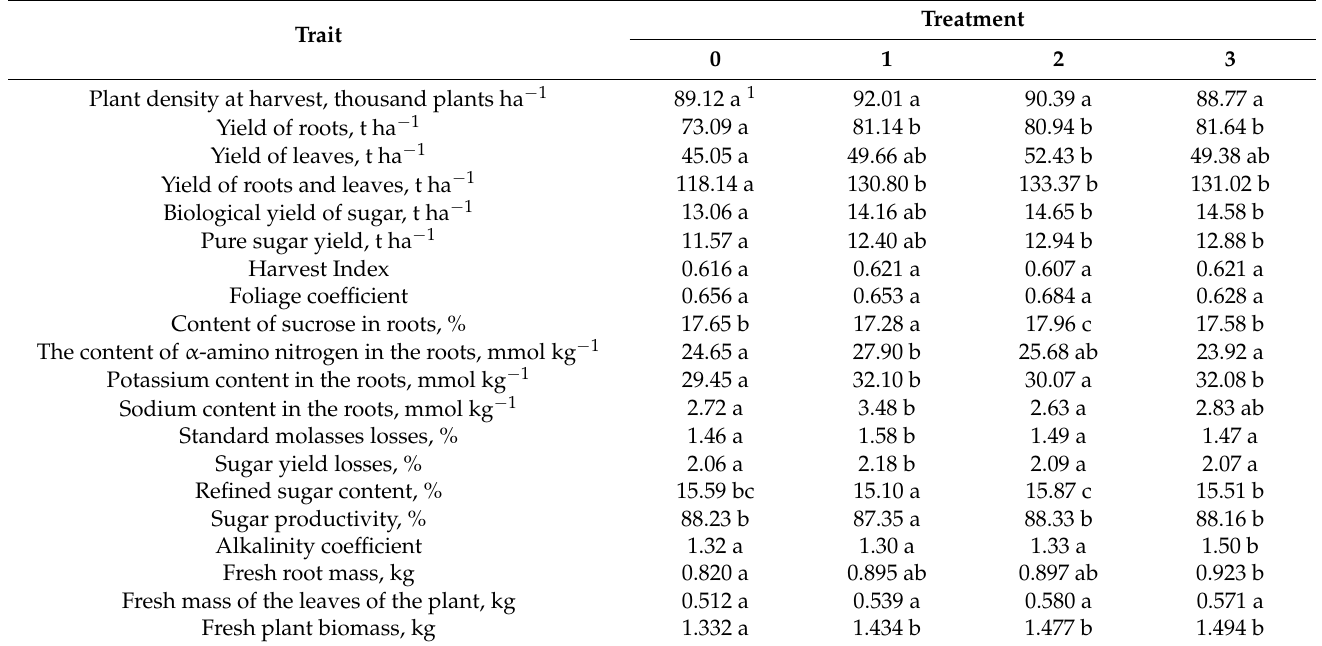
Table 4. The influence of various forms of silicon on the yield, the technological quality of the roots and the traits of sugar beet plants